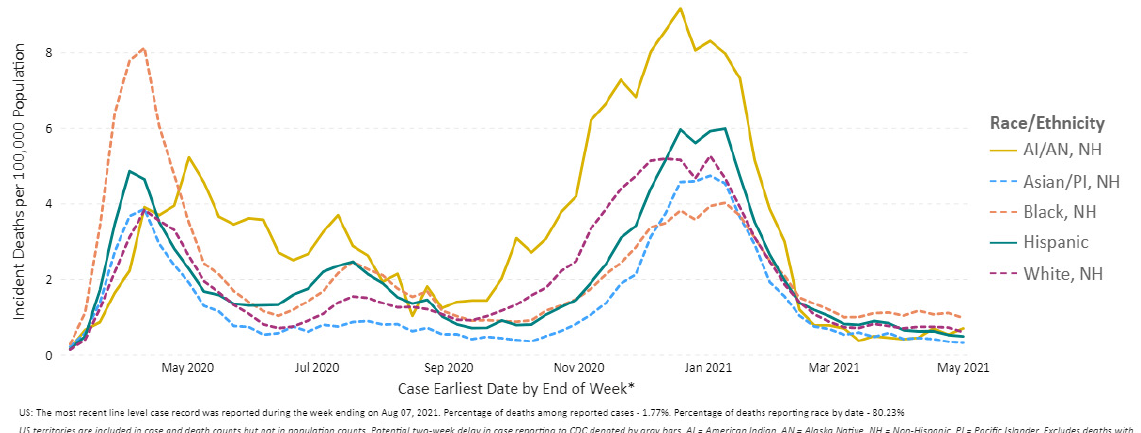
Figure 7. COVID-19 Weekly Deaths per 100,000 Population by Race/Ethnicity, United States between 1 March 2020 and 1 May 2021 (Source: Reproduced from the CDC) [4].